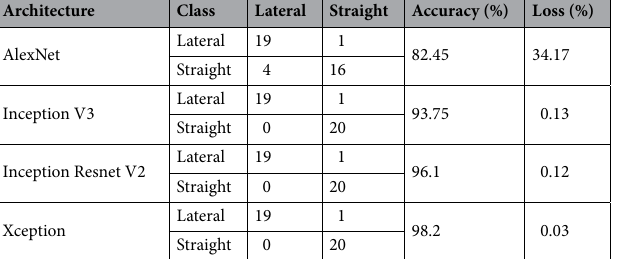
Table 2. The confusion matrix representing each of the architectures across ten runs, where the false and true positive predictions for each class are represented.